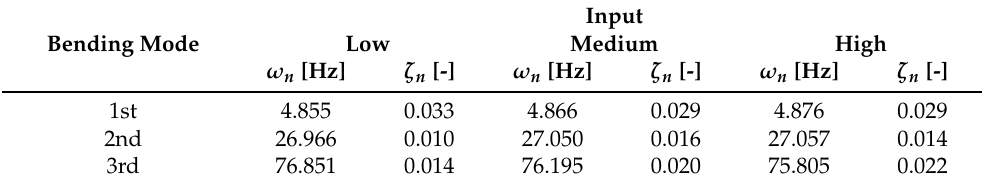
Figure 13. Main spar: Stabilisation diagrams showing the low-input scenario computed with the following parameters: ∆ f = 1%, ∆ ζ = 5% and MAC = 0.95. The FRF of channels # 3L and 4L are superimposed for further mode visualisation. Table 9. Main Spar: natural frequency and damping ratio